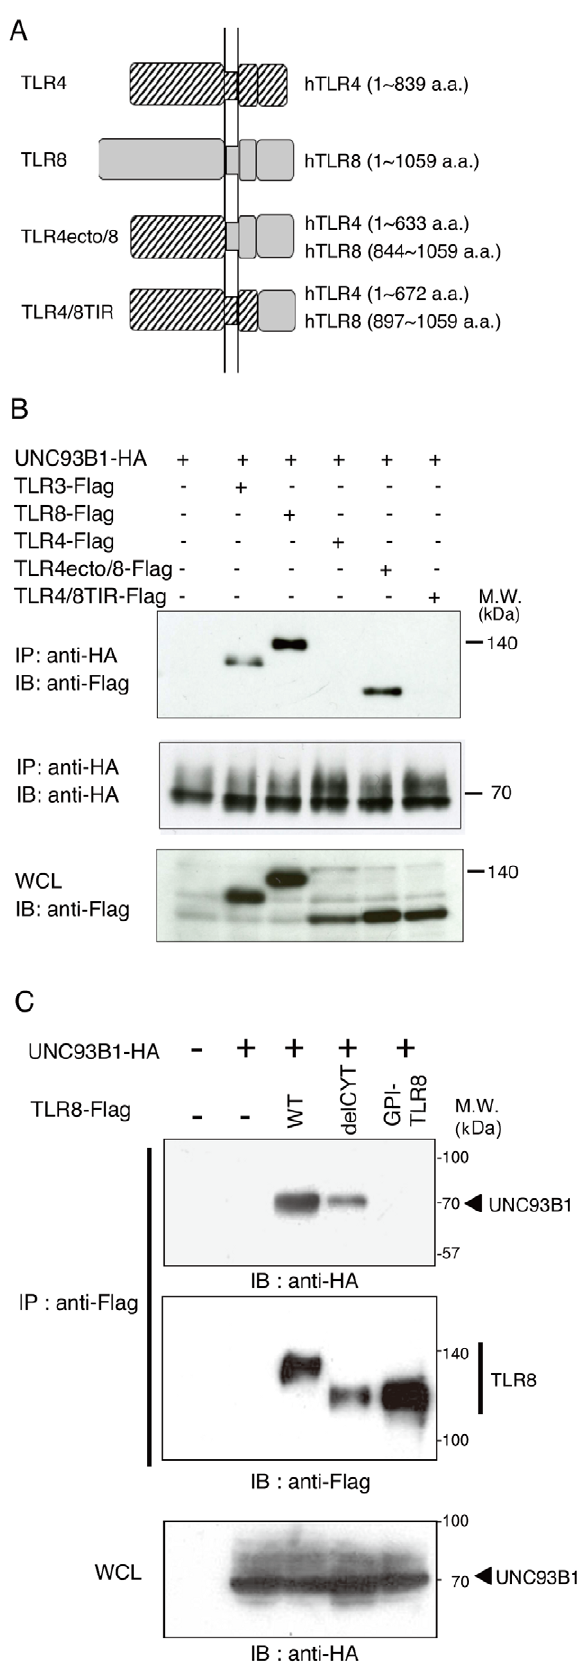
Figure 3. UNC93B1 physically associates with TLR8 through the transmembrane domain in HEK293FT cells. A , Schematic diagram of the TLR4/8 chimeric receptor constructs. B , C, HEK293FT cells were transfected with the corresponding vectors for expression of the indicated proteins. Twenty-four hours after transfection, cells were lysed in lysis buffer. The lysates were immunoprecipitated (IP) with anti-HA pAb ( B ) or anti-FLAG pAb ( C ), resolved using SDS-PAGE, and detected using immunoblotting (IB) with anti-FLAG M2 mAb or anti-HA mAb. Whole cell lysates (WCL) were subjected to immunoblotting with anti- FLAG mAb ( B ) or anti-HA mAb ( C ) to detect protein expression. Molecular weight markers are shown on the